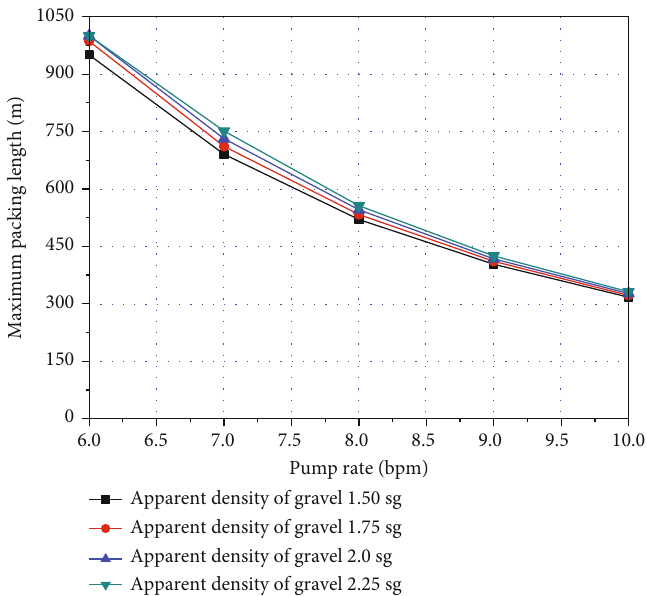
Figure 6: E ff ect of di ff erent gravel density on packing length.